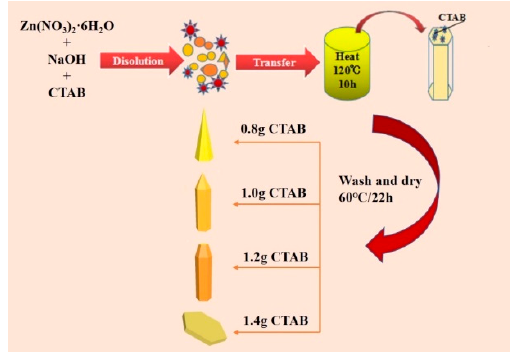
Figure 3. Schematic illustration of the possible formation process for ZnO particles arrays with different amounts of CTAB.